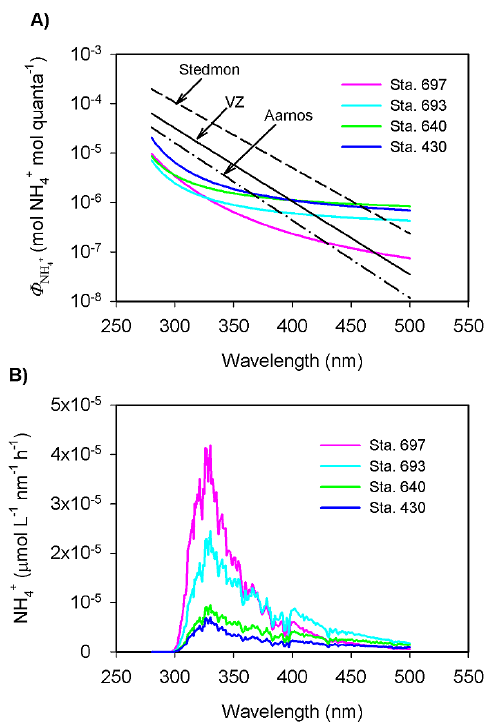
Fig. 6. Examples of apparent quantum yield (A) and action (B) spectra of photoammonification. Also shown in panel (A) are AQY spectra from the literature. VZ stands for V¨ah¨atalo and Zepp (2005) (station LL12), Stedmon for Stedmon et al. (2007) (station Kotka), and Aarnos for Aarnos et al. (2012) (station III-Gulf of